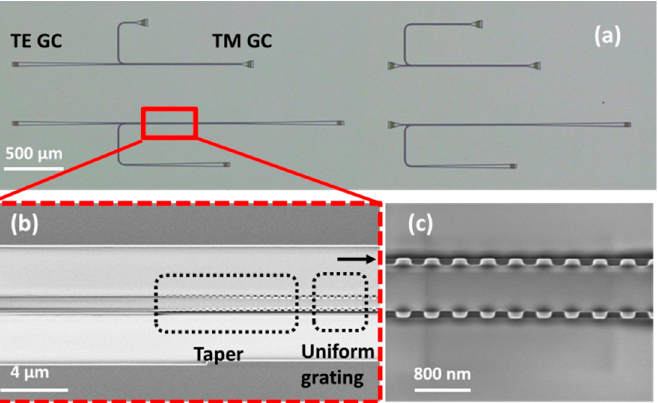
Figure 11. ( a ) The microscope image for the fabricated PSR. The scanning electric microscopy (SEM) image for ( b ) linearly taper section and ( c ) zoom-in of uniform grating section.